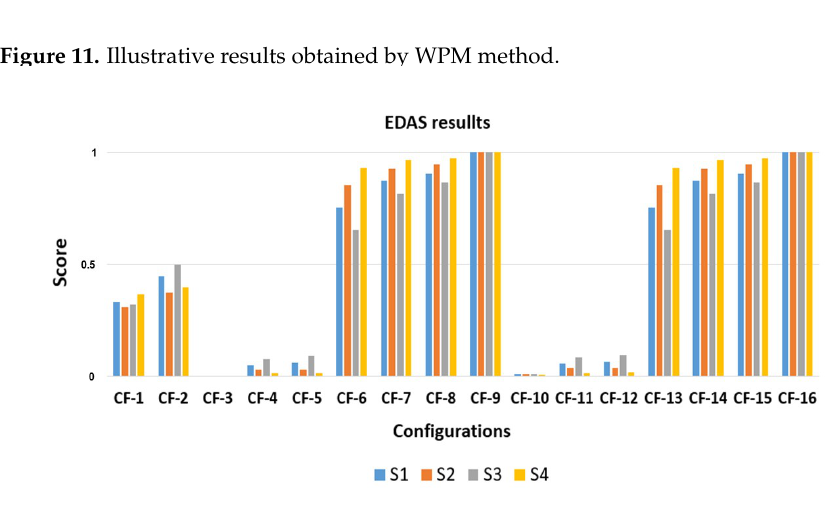
Figure 12. Illustrative results obtained by EDAS